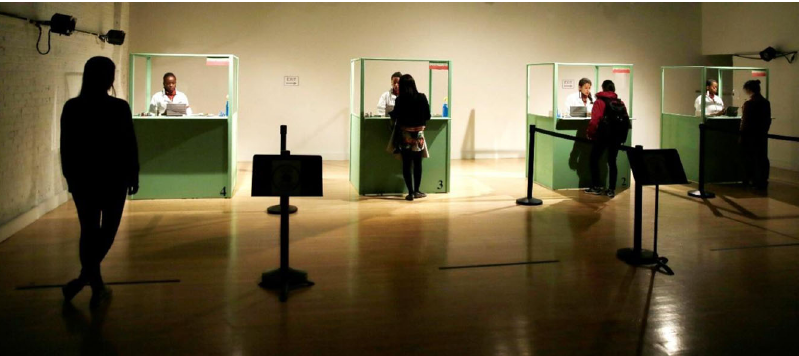
Fig. 5 | The performance-experiment setting in Study 4. Participants met actresses who were seated in a theatrical set inspired by the architecture of “ airport immigration booths ” welcoming one participant at a time for an “ entry ” interview.